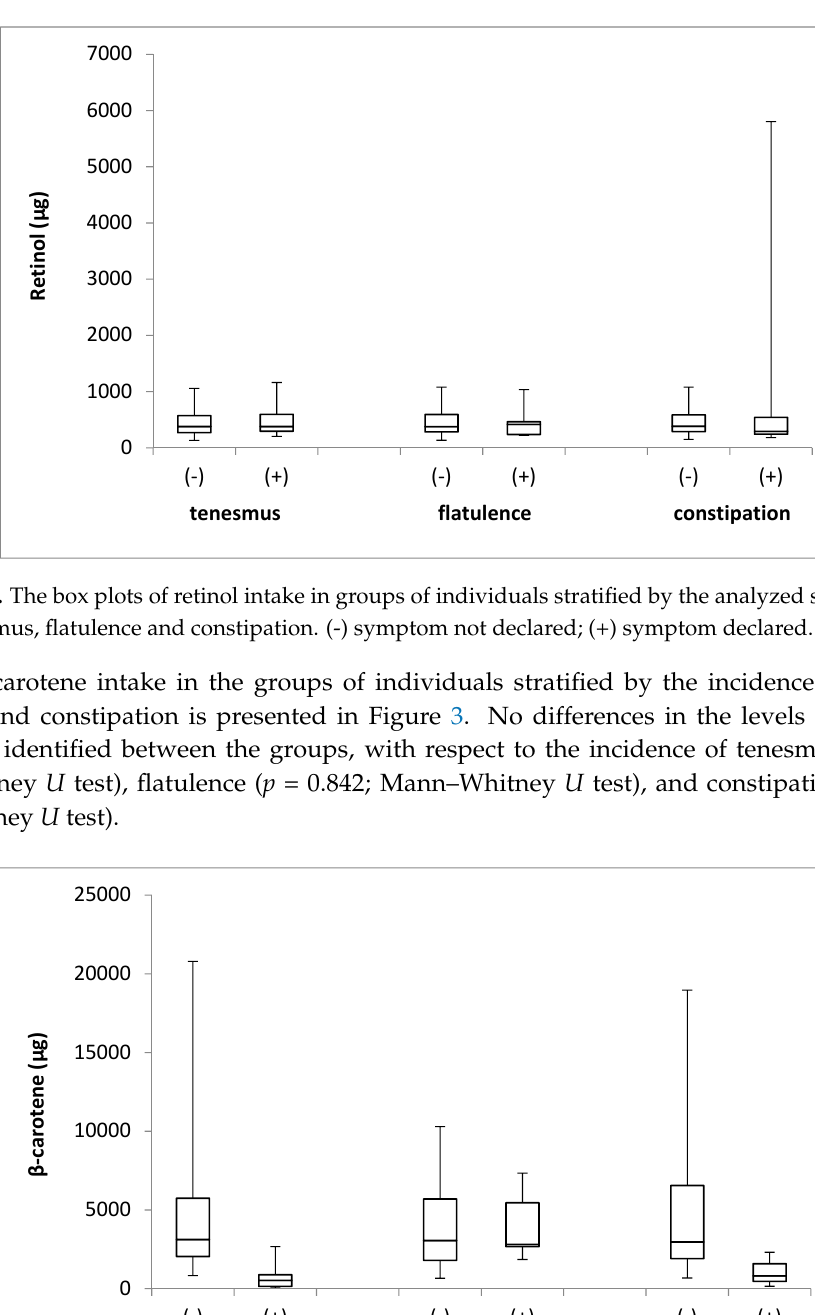
Figure 1. The box plots of vitamin A intake in groups of individuals stratified by the analyzed symptoms of tenesmus, flatulence and constipation. (-) symptom not declared; (+) symptom declared. The retinol intake in the groups of individuals stratified by the incidence of tenesmus, flatulence, and constipation is presented in Figure 2. No differences in the levels of retinol intake were identified between the groups, with respect to the incidence of tenesmus ( p = 0.740; Mann–Whitney U test), flatulence ( p = 0.964; Mann–Whitney U test), and constipation ( p = 0.674; Mann–Whitney U test).